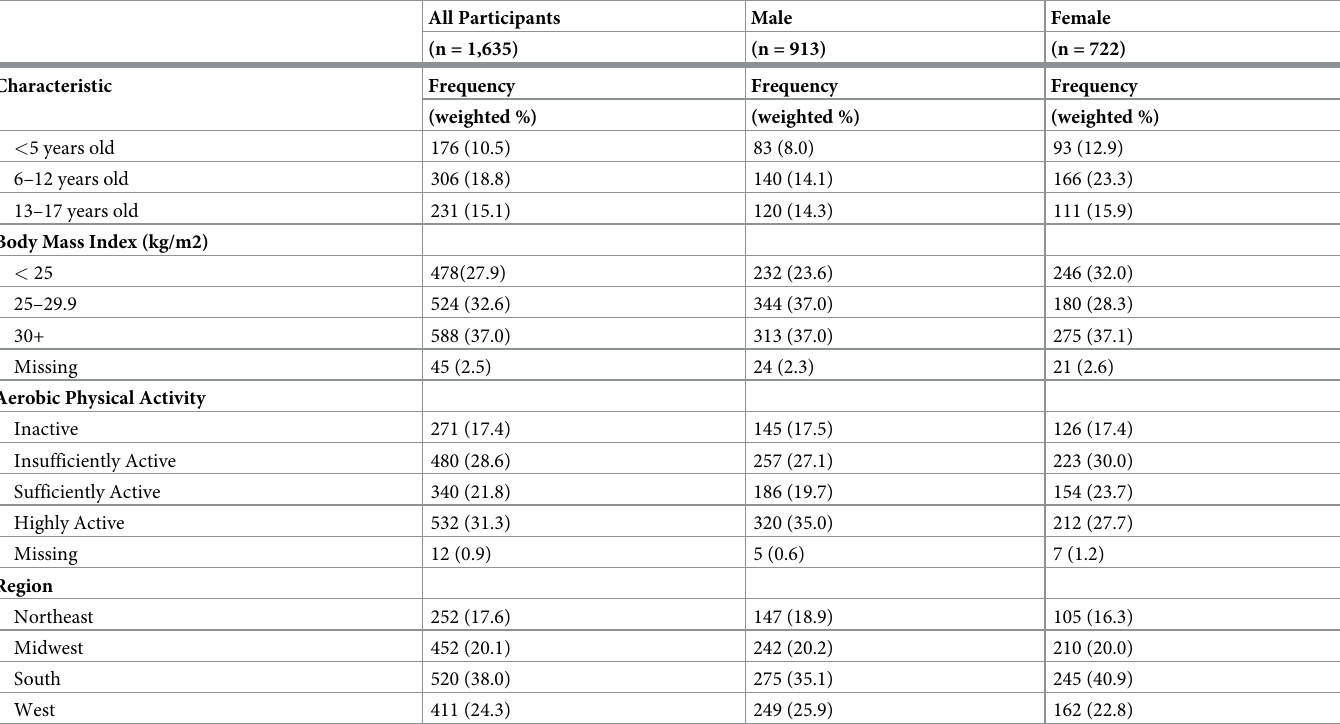
Table 2). Significant domain specific differences (p < 0.05) were observed for overall time use (i.e., combined sedentary and active) with an increase in overall leisure time (0.40 hrs/d) in 2020, and reductions in total transportation in 2020 (-0.47 hrs/d; Fig 1, Panel B; Table 3). The apparent reallocation of time from transport to discretionary leisure-time in 2020 co-occurred with an increase in time spent in sedentary leisure pursuits (+0.46 hrs/d; Fig 1, Panel C; Table 3), but there was no change in physical activity during leisure-time (-0.06 hrs/d; Fig 1, Panel D; Table 3). Further analysis indicated that increased sedentary leisure time was driven by increased screen time (0.45 hrs/d). Significant reductions in sedentary (-0.44 hrs/d; Panel C; Table 3) and active transport (-0.03 hrs/d; Fig 1, Panel D; Table 3) were also observed. Longitudinal changes by sex, age, and race-ethnicity There were no significant changes in time reported in the daily behaviors pre-pandemic (2019) to 2020 in men, but women reported significantly less total physical activity (-0.36 hrs/ d, Table 2). Men reported a significant increase in total leisure-time (0.48 hrs/d), but women did not (0.34 hrs/d). Both sexes reported similar reductions in total transportation time in 2020 (Table 3). Both men and women appeared to use time saved in transportation in seden- tary rather than physically active pursuits. Further analysis indicated sedentary screen time during leisure was significantly greater in 2020 in women (0.48 hrs/d) and men (0.44 hrs/d). Men also reported less sedentary housework in 2020 (Table